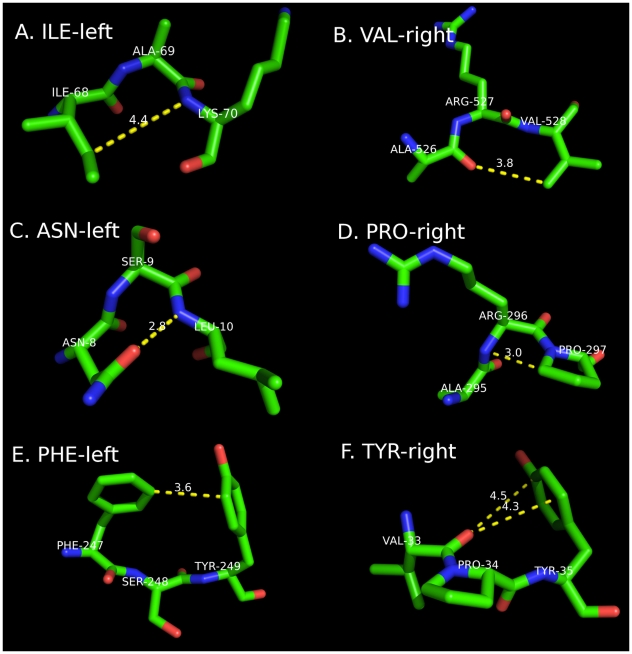
Neighbor-dependent effects.
A. ILE (left) – ALA (center conformation A, coil, PDB entry 1N55, residue 69 of chain A). Ile likely prevents H-bond acceptor to Ni+1. B. VAL (right) – ARG (cent, A, coil, 2FWH_527A). Val likely prevents H-bond donor to Oi−1. C. ASN (left) – SER (cent, A, coil, 3C8W_9A). Asn forms hydrogen bond to Ni+1. D. PRO (right) – ARG (cent, A, coil, 2RKV_296A). Very close steric bump of Pro CD with Ni. E. PHE (left) – SER (cent, B, coil, 2GS8_248A). Favorable hydrophobic interaction with Tyri
+1. F. TYR (right) – PRO (cent, P, turn, 3CA8_34A). Tyr unfavorable electro. interaction with Oi−1.